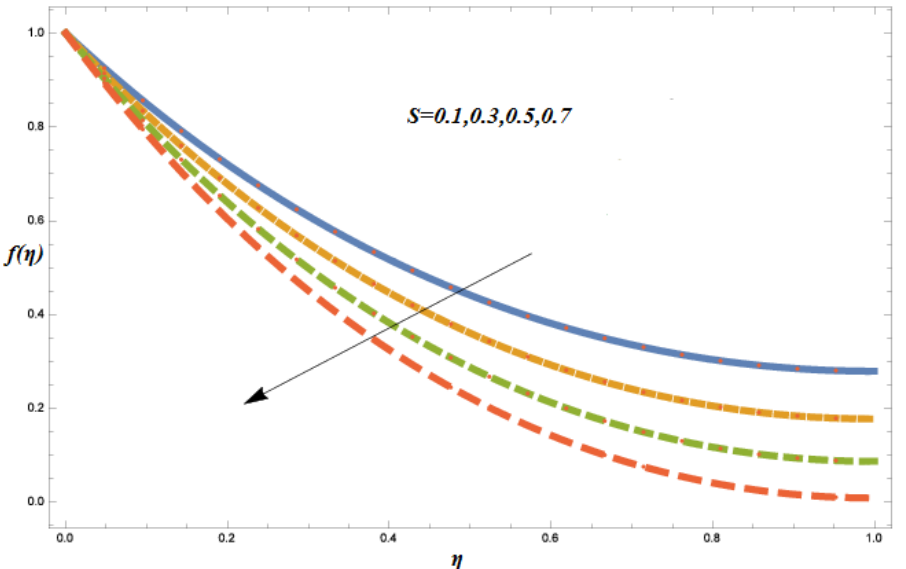
Figure 7. Variants in velocity field f ( η ) for various values of S , when (cid:125) = − 0.25, P r = 10, D u = 0.7, S c = 0.7, λ = 0.7, Λ = 0.7, β = 1.